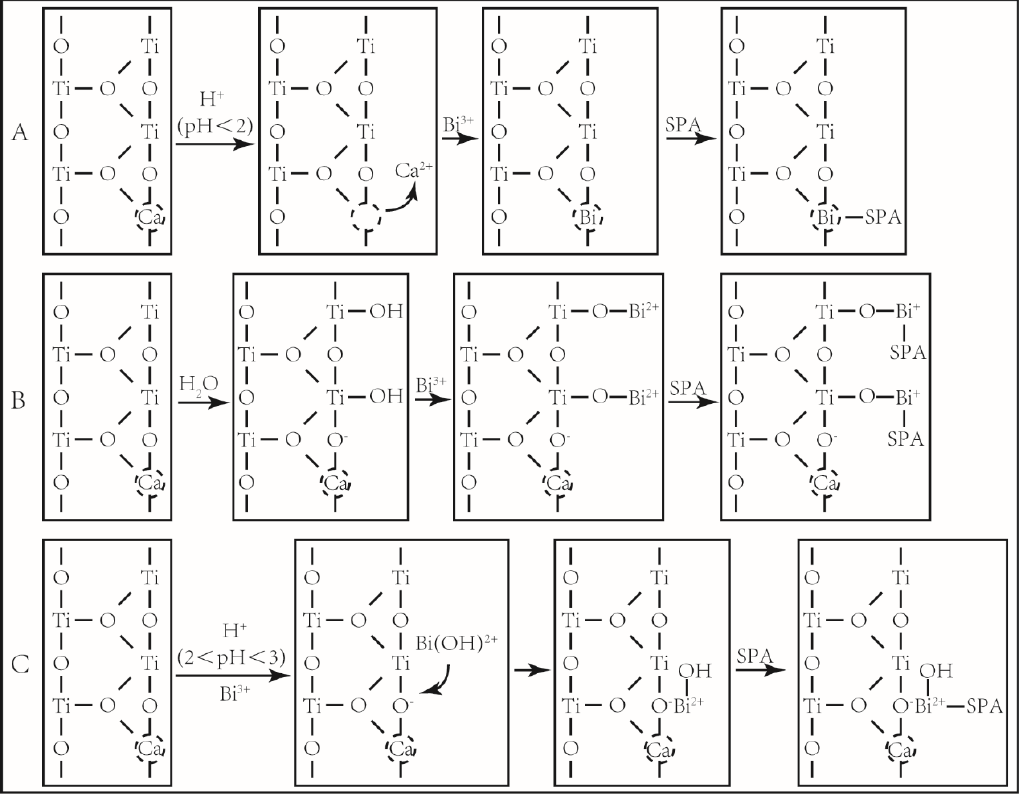
Figure 11. The models of the activation mechanism of Bi 3+ to rutile flotation. (A): Occupying the vacancy left by Ca 2+ ions dissolution; (B): the proton substitution reaction; (C): increasing the activation sizes in the form of hydroxyl species.